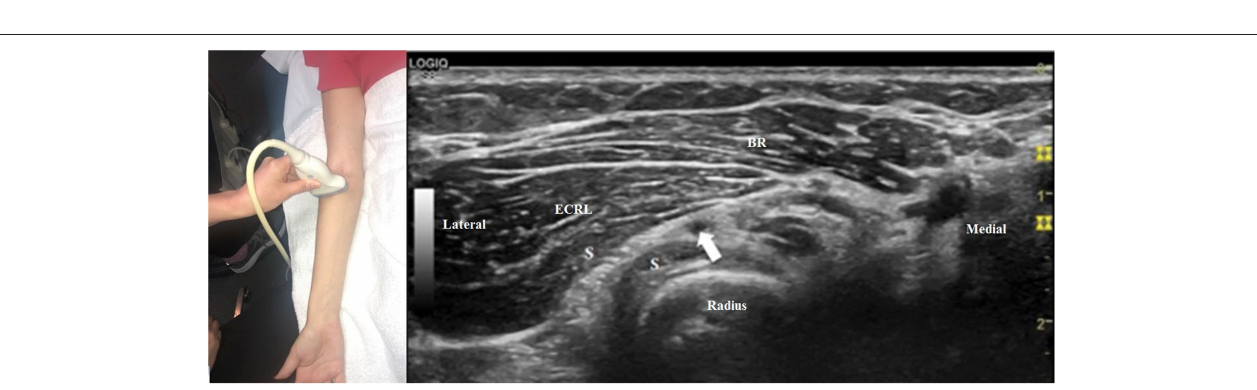
FIGURE 3 | The transducer is now just distal to its position in Figure 1 . The motor branch of the radial nerve (arrow) is just beginning to enter the arcade of Frohse, between the two layers of the supinator muscle (S). BR, brachioradialis; ECRL, extensor carpi radialis longus.